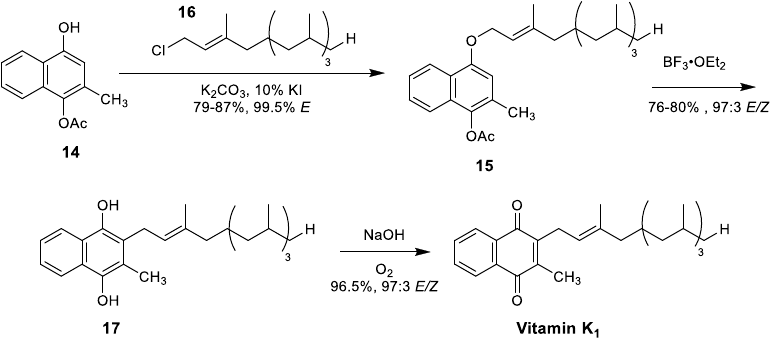
Table 2. Friedel-Crafts alkylation of 18 with sulfonyl 19 to form 20 [65]. Lewis Acid